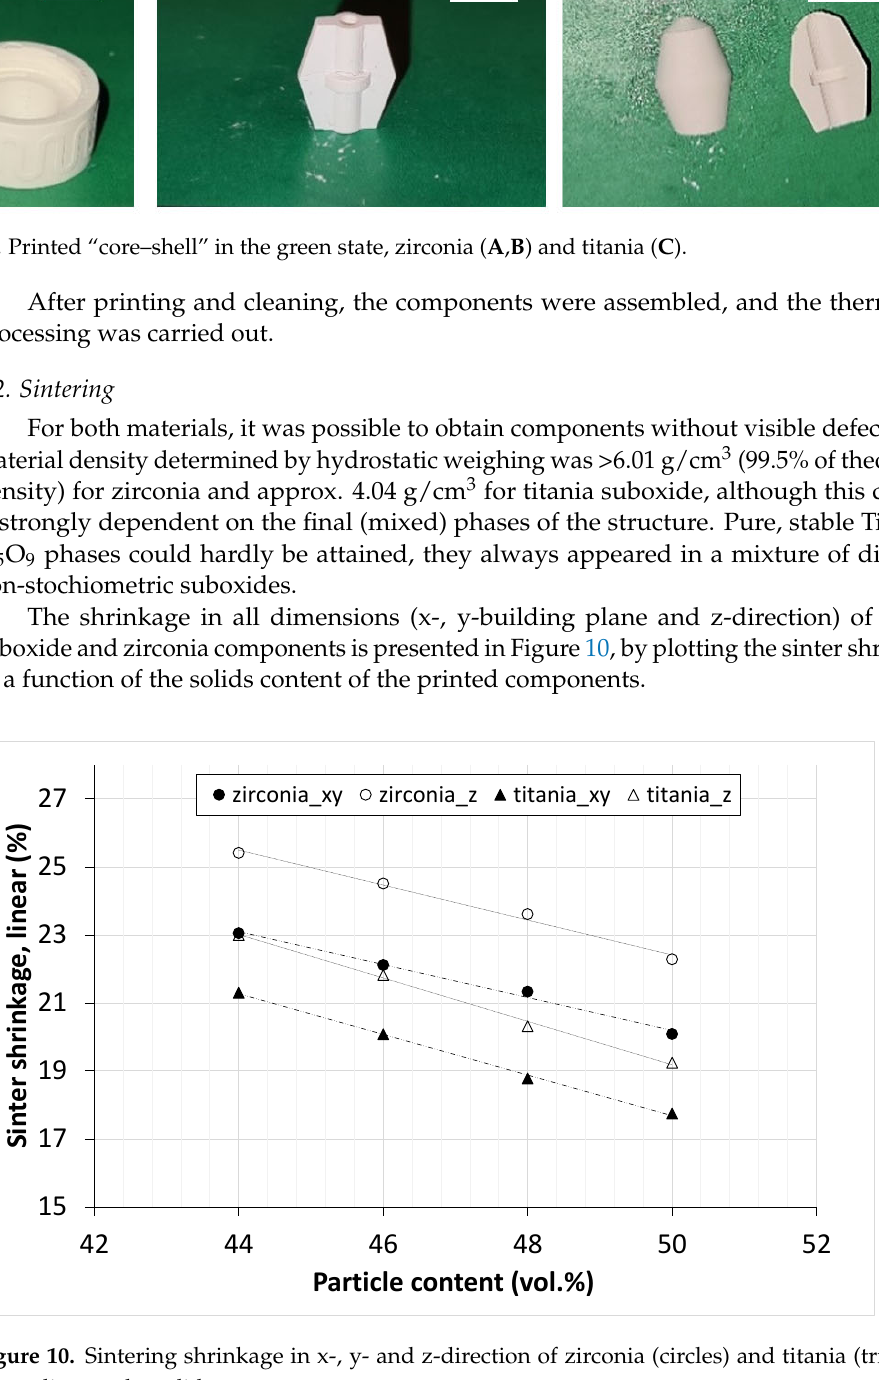
Figure 9. Printed “core–shell” in the green state, zirconia ( A , B ) and titania ( C ) .